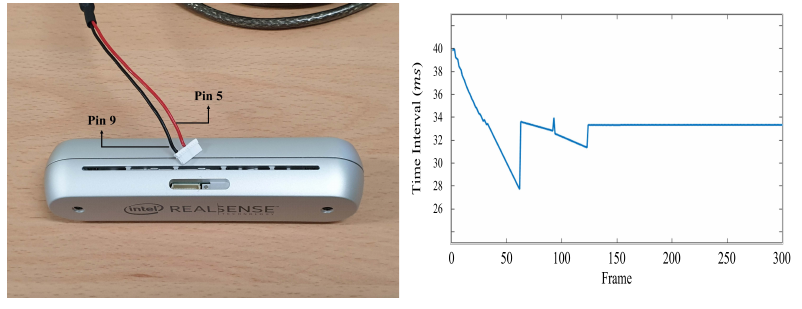
Figure 7. Reception of the trigger signal by the RealSense